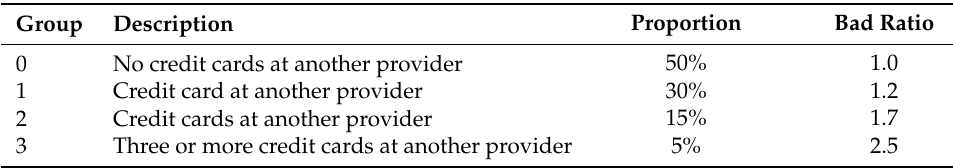
Table 2. Credit cards with other